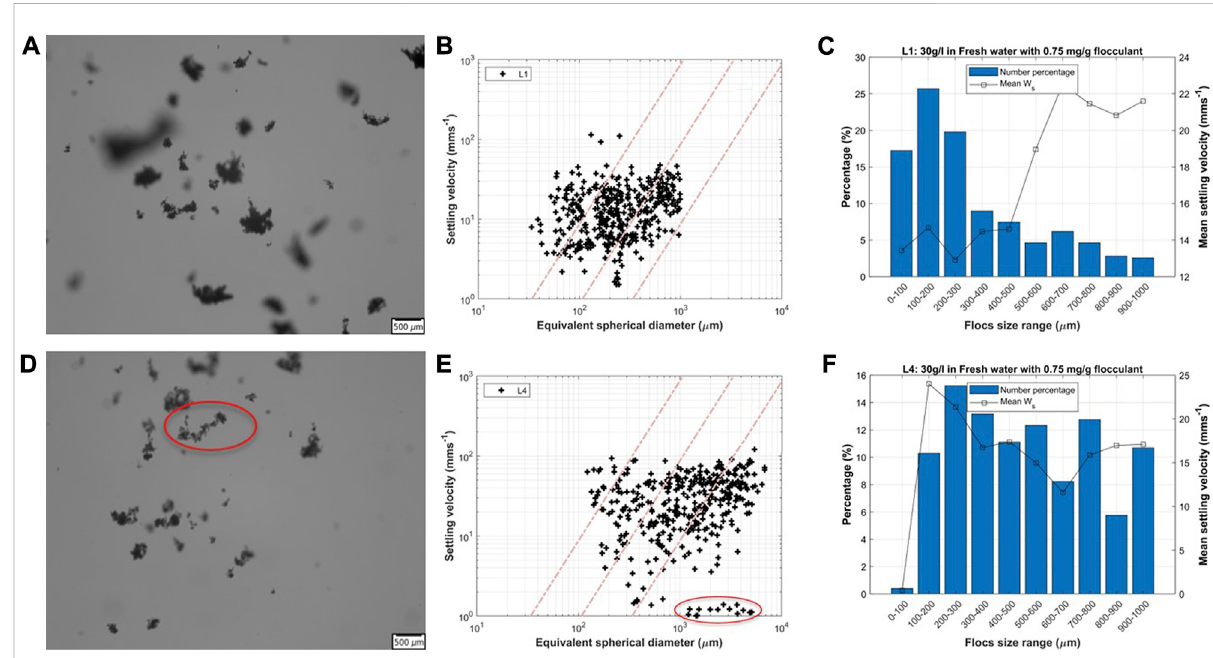
FIGURE 10 Figures (A,D) snapshots of the videos; Figures (B,E) : Settling velocity and particle size analysis of the samples collected at location L1 and L4 during lock exchange experiments with 30 g L − 1 ACCZ and 0.75 mg g − 1 of fl occulant in freshwater (Ali et al., 2022). Settling velocity is derived as a function of equivalent spherical diameter, with diagonal dashed lines representing the contours of effective density calculated by using Stokes equation (from left to right: 1600, 160, 16 (kgm − 3 )). Figures (C,F) show fl oc size range and mean settling